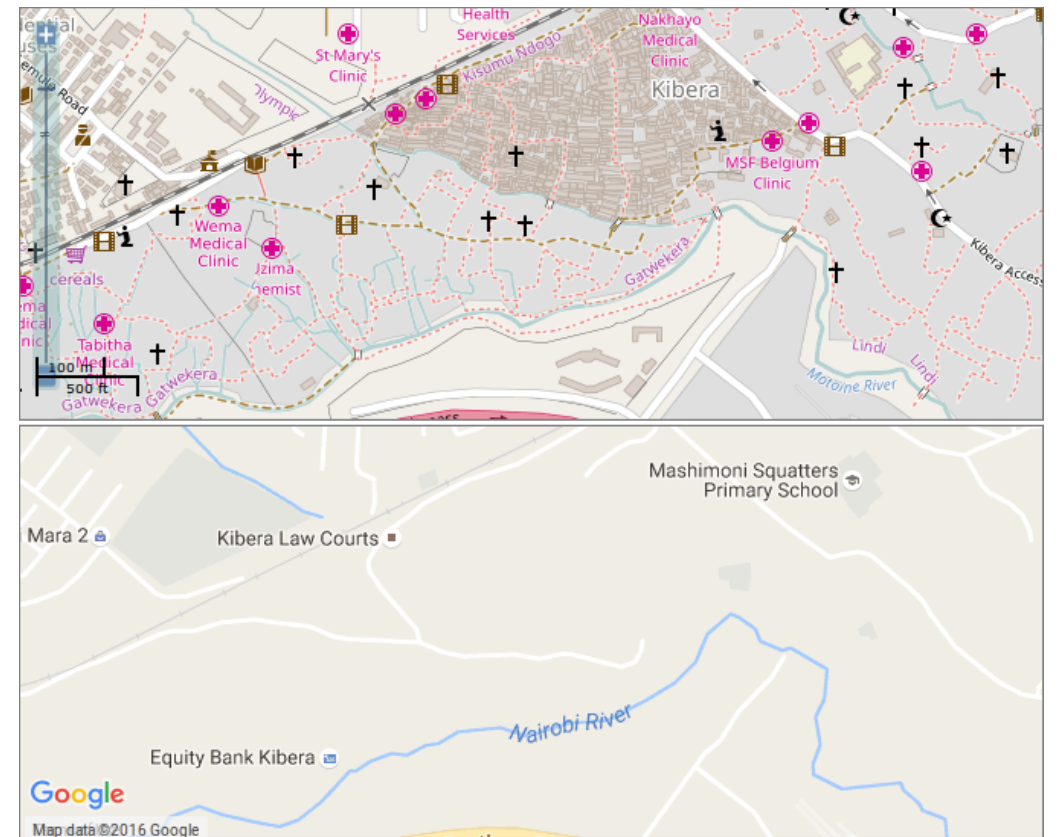
Figure 1. Comparison between OpenStreetMap (OSM) ( top ) and Google Maps ( bottom ) showing the Kibera slum in Nairobi. Copyright: © OpenStreetMap contributors.